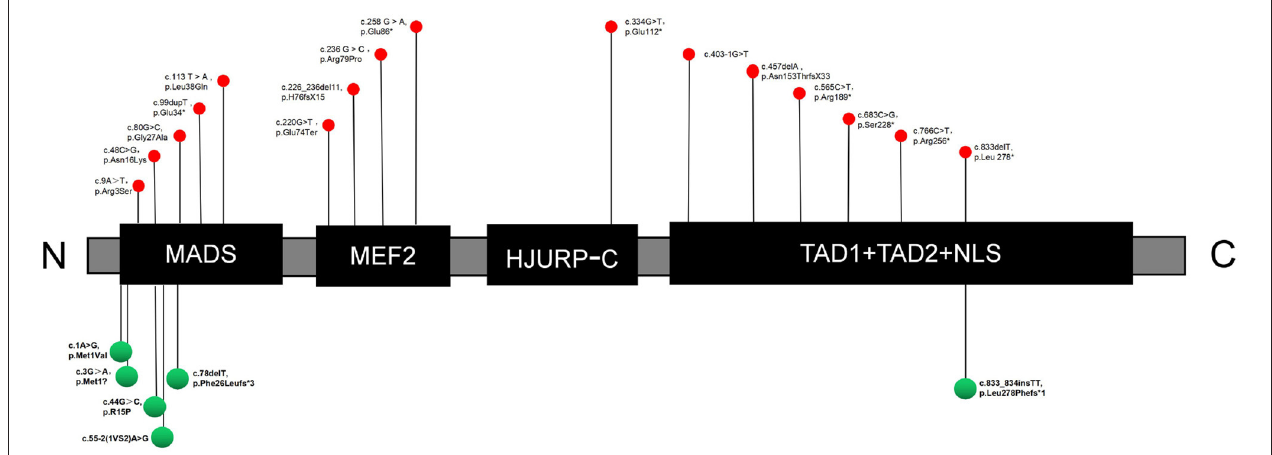
FIGURE 1 | Sites of mutations in the MEF2C protein. Red and green indicate reported mutations and novel mutations detected in this study, respectively. C, C-terminus; N, N-terminus; MADS, MCM1, agamous, deficiens, serum response factor; MEF2, myocyte enhancer factor 2; HJURP-C, Holliday junction recognition protein C-terminal; NLS, nuclear location signal; TAD, transcriptional activation